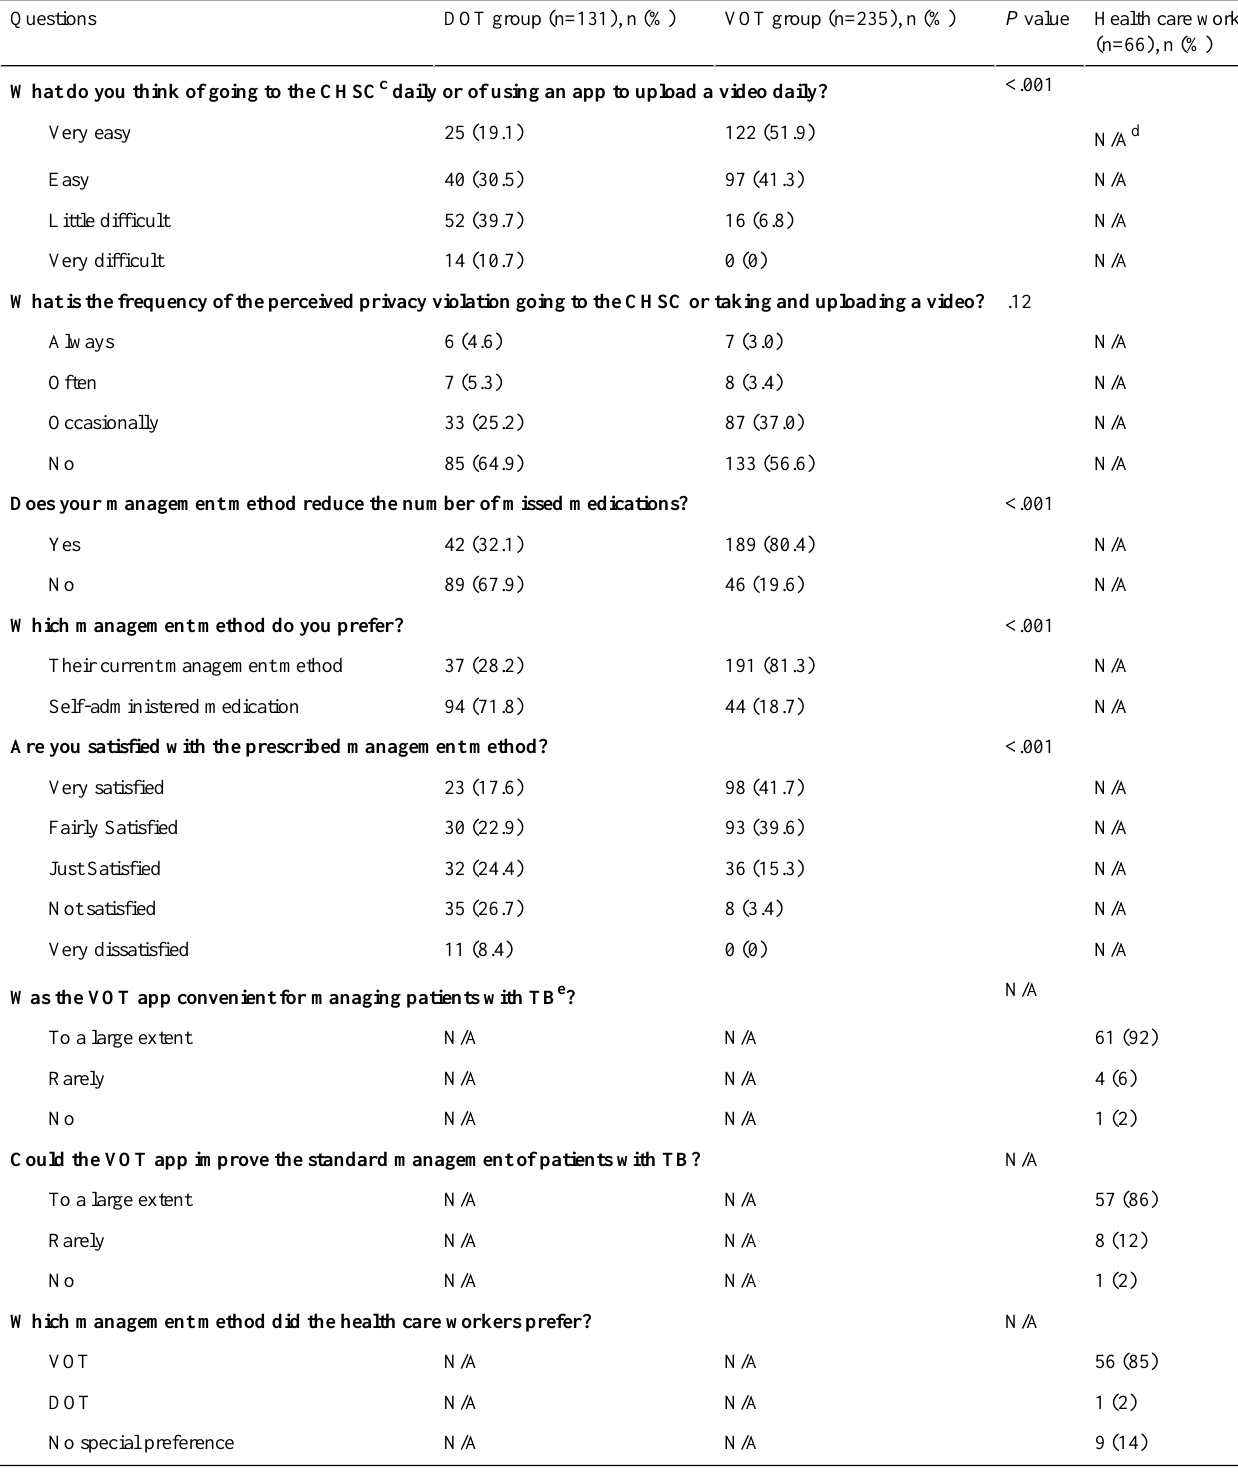
Table 5. Measurements of the satisfaction of the patients and the health care workers with the DOT a or VOT b methods.